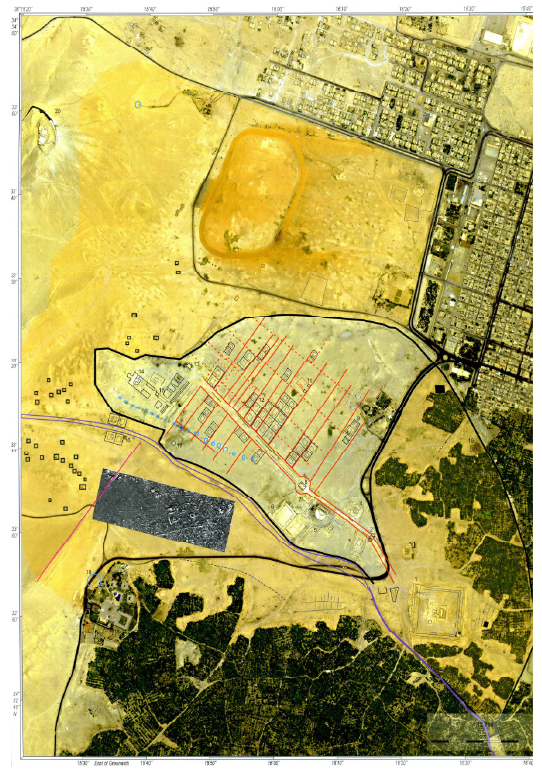
Figure 8. A satellite map of Palmyra. The tower tombs are visible to the left as small black squares. Courtesy: GORS, Damascus